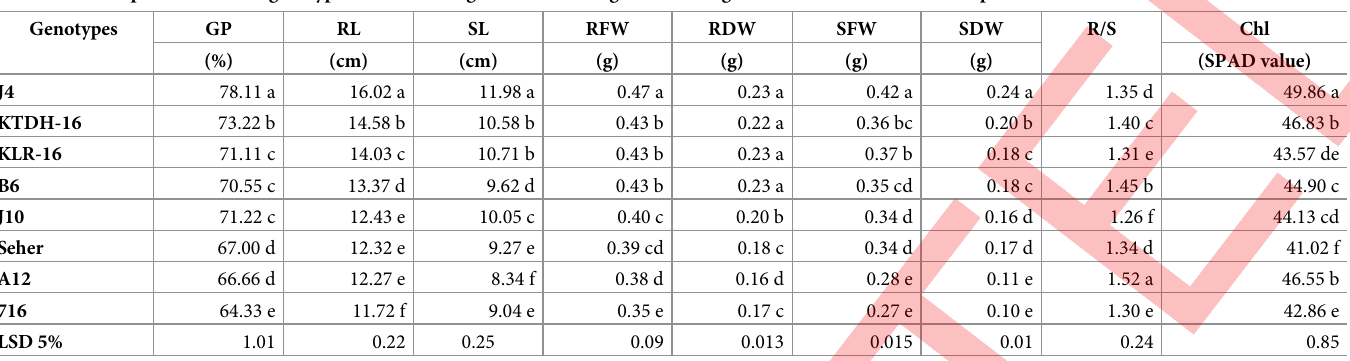
Table 2. The impact of different genotypes on their seed germination and growth traits grown under different osmotic potentials. Genotypes